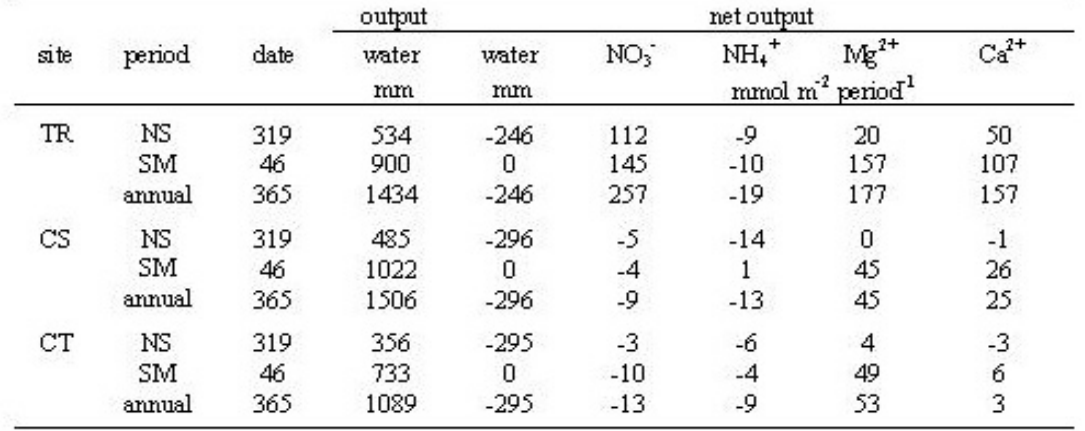
Net Output (Output-Input) of Elements and Water from Rooted Soil (40 cm) during the Snowmelt Period (from April to late May: SM), Other Periods (No-Snow